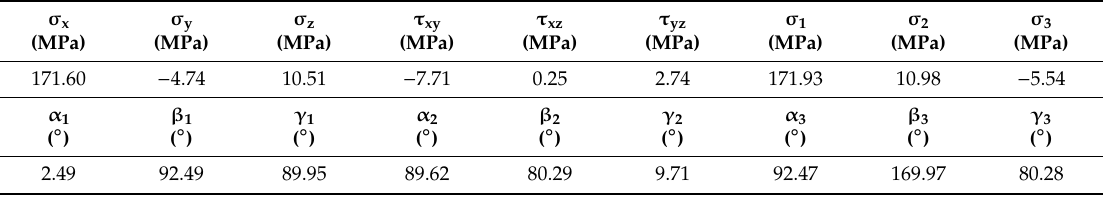
Table 2. Values of stress components at the point located on the flank of a flange with a diameter at which cracking occurs (denotations according to Figure